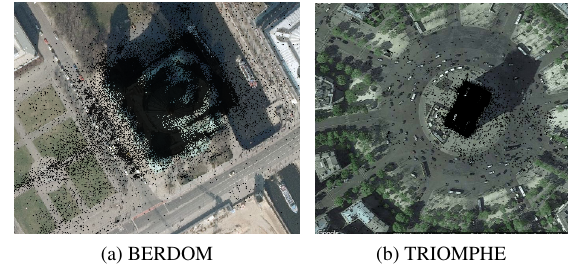
Figure 7. Result for BERDOM and TRIOMPHE dataset after geo-referencing (TRIOMPHE image courtesy of Google